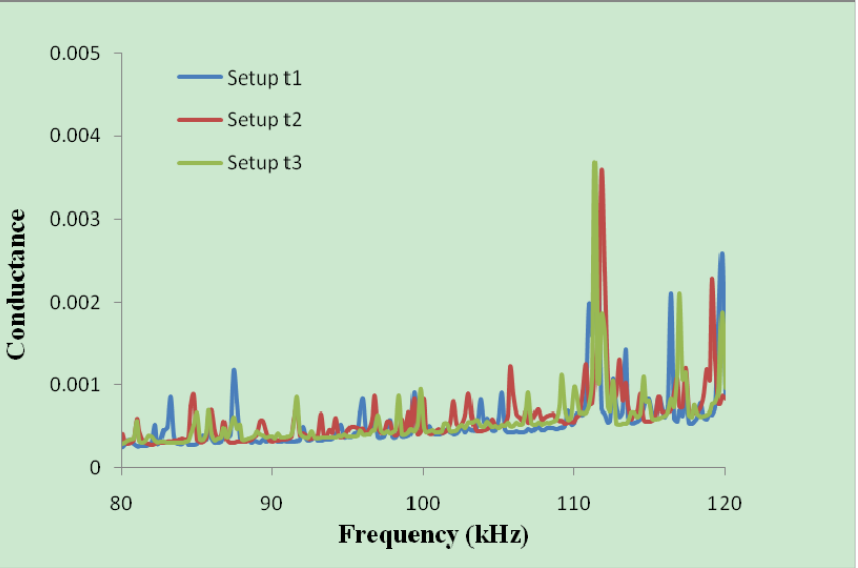
Figure 7. Repeatability of signatures for three